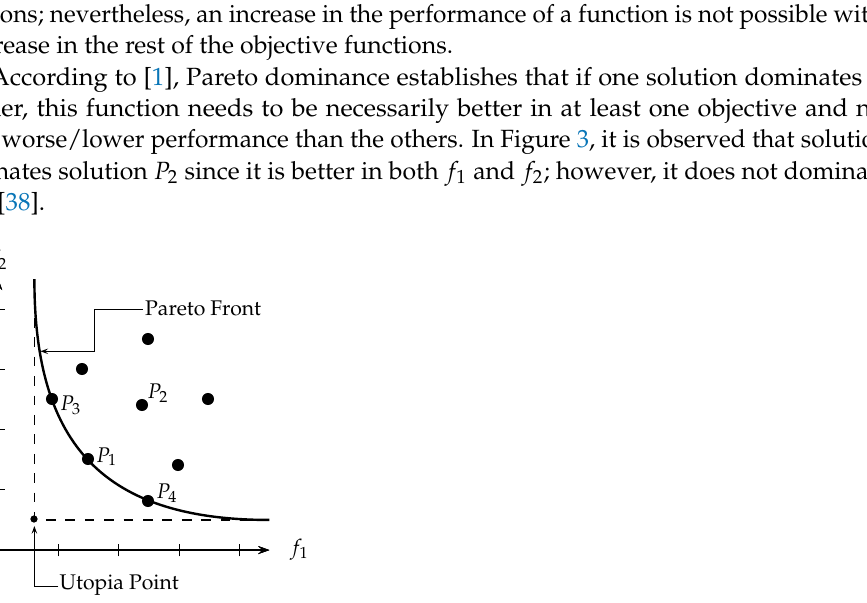
Figure 3. Example of the Pareto optimal front and the utopia